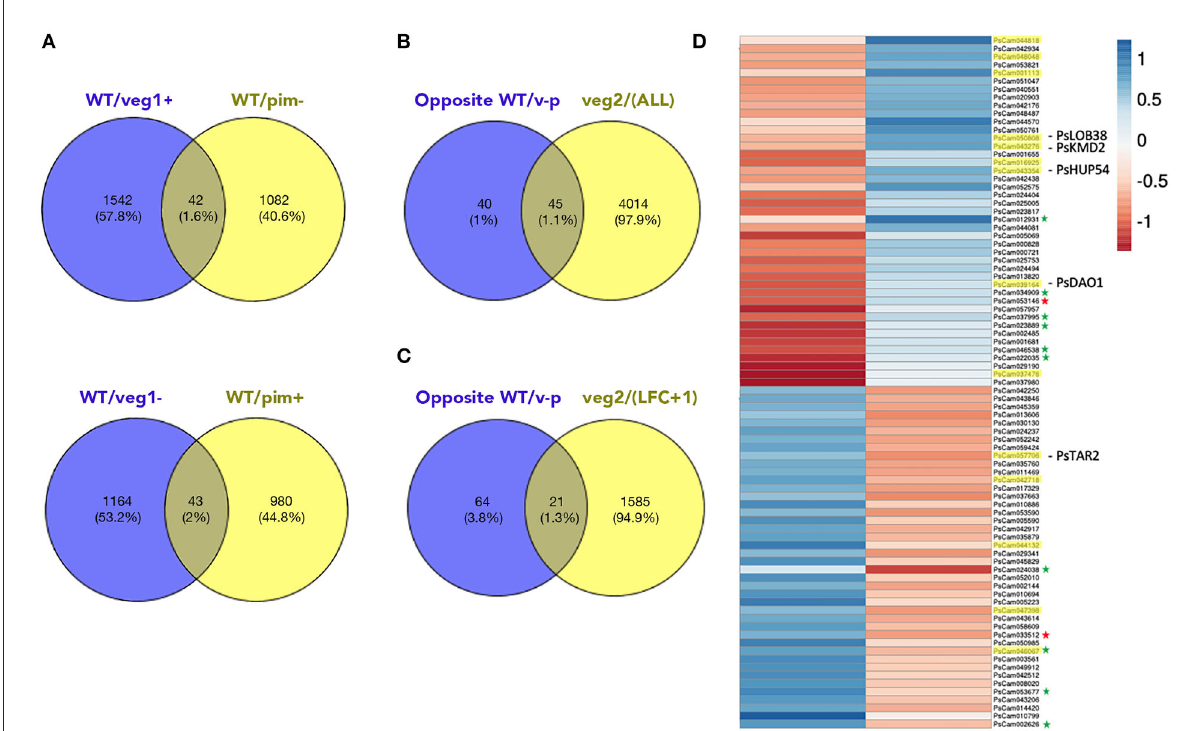
FIGURE3 Transcriptome analysis of veg1 , pim, and veg2 apex samples compared to wild type. (A) Venn diagrams displaying genes with an opposite expression pattern in WT/ veg1 and WT/ pim comparisons: 43 genes are downregulated in veg1 (WT/veg1–) and upregulated in pim (WT/ pim + ) (lower panel); 42 genes are upregulated in veg1 (WT/ veg1 + ) and downregulated in pim (WT/ pim -) (top panel). (B) Venn diagram identifying differentially expressed genes in WT/ veg2 among those with an opposite expression pattern in veg1 and pim mutant backgrounds (opposite WT/v-p). (C) Venn diagram identifying differentially expressed genes in WT/ veg2 with a log of fold change > 1 among those with an opposite expression pattern in veg1 and pim mutant backgrounds (opposite to WT/v-p). (D) Heatmap displaying expression change of the 85 genes with an opposite expression pattern in WT/ veg1 and WT/ pim (red shows downregulation of the gene in the mutant compared to the WT and blue indicates upregulation). Genes highlighted in yellow were selected for further characterization. Validation of the RNA-seq data was performed for 12 genes (marked with a star). We confirmed the opposite expression pattern in 10 out of 12 of those genes (green star). For two of the genes, the expression profile could not be confirmed (red star) (Supplementary Figure